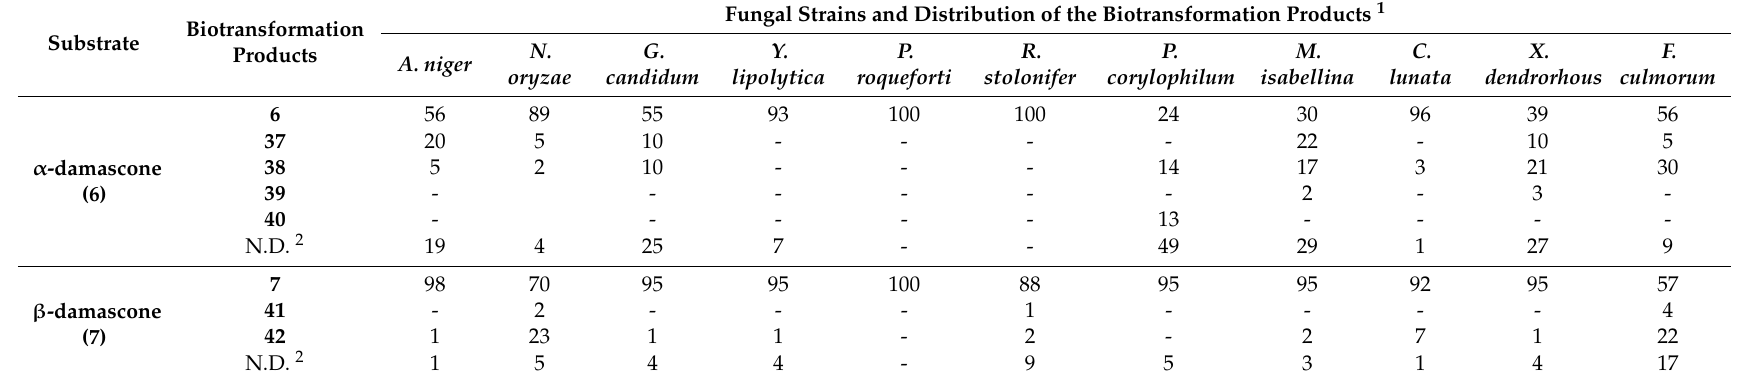
Table 3. Results of the fungi-mediated biotransformation of α - and β -damascone